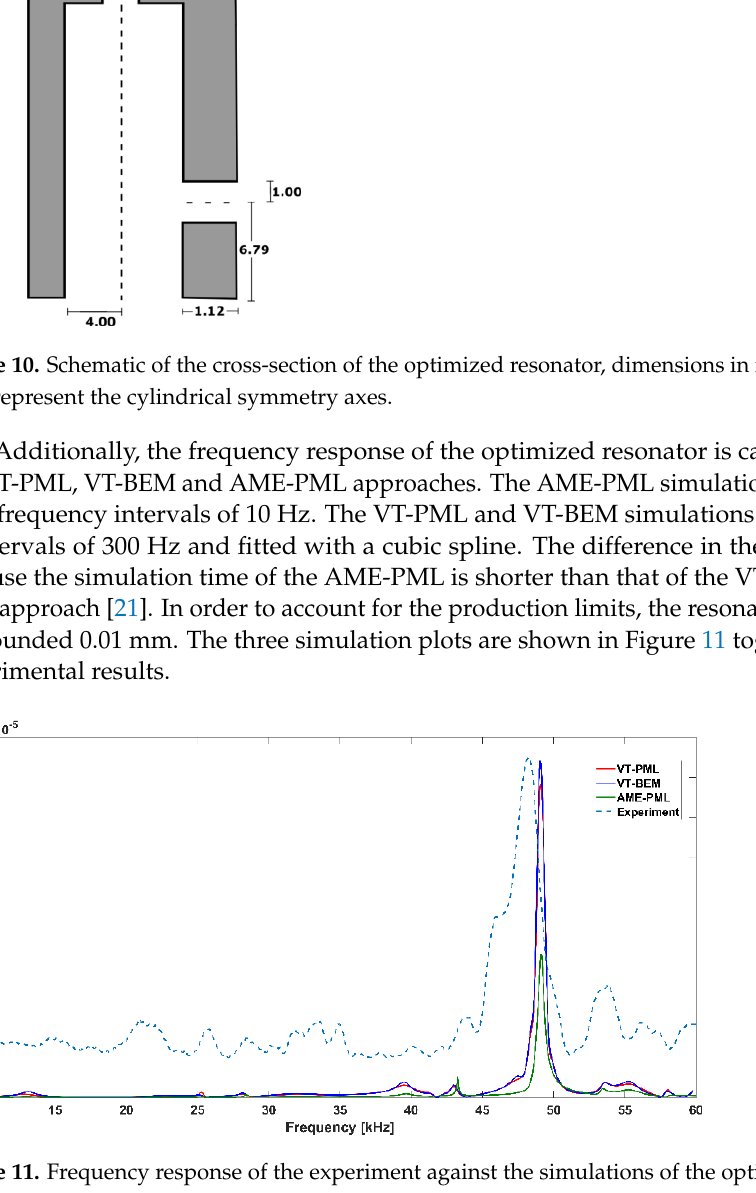
Figure 11. Frequency response of the experiment against the simulations of the optimized resonator. The blue, red and green plots represent the VT-PML, VT-BEM and AME-PML approach, respectively. The blue dashed line shows the experimental measurement.